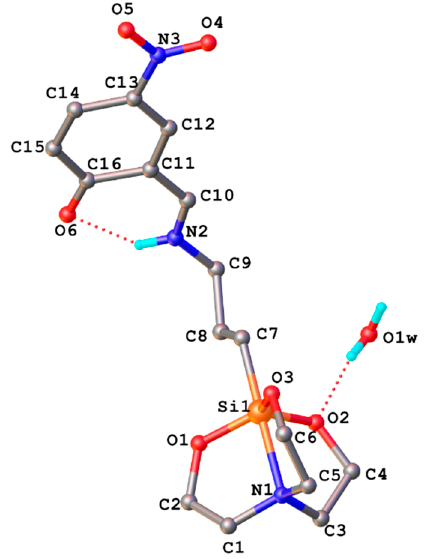
Figure 1. X-ray structure of the asymmetric part of SIL-BS.